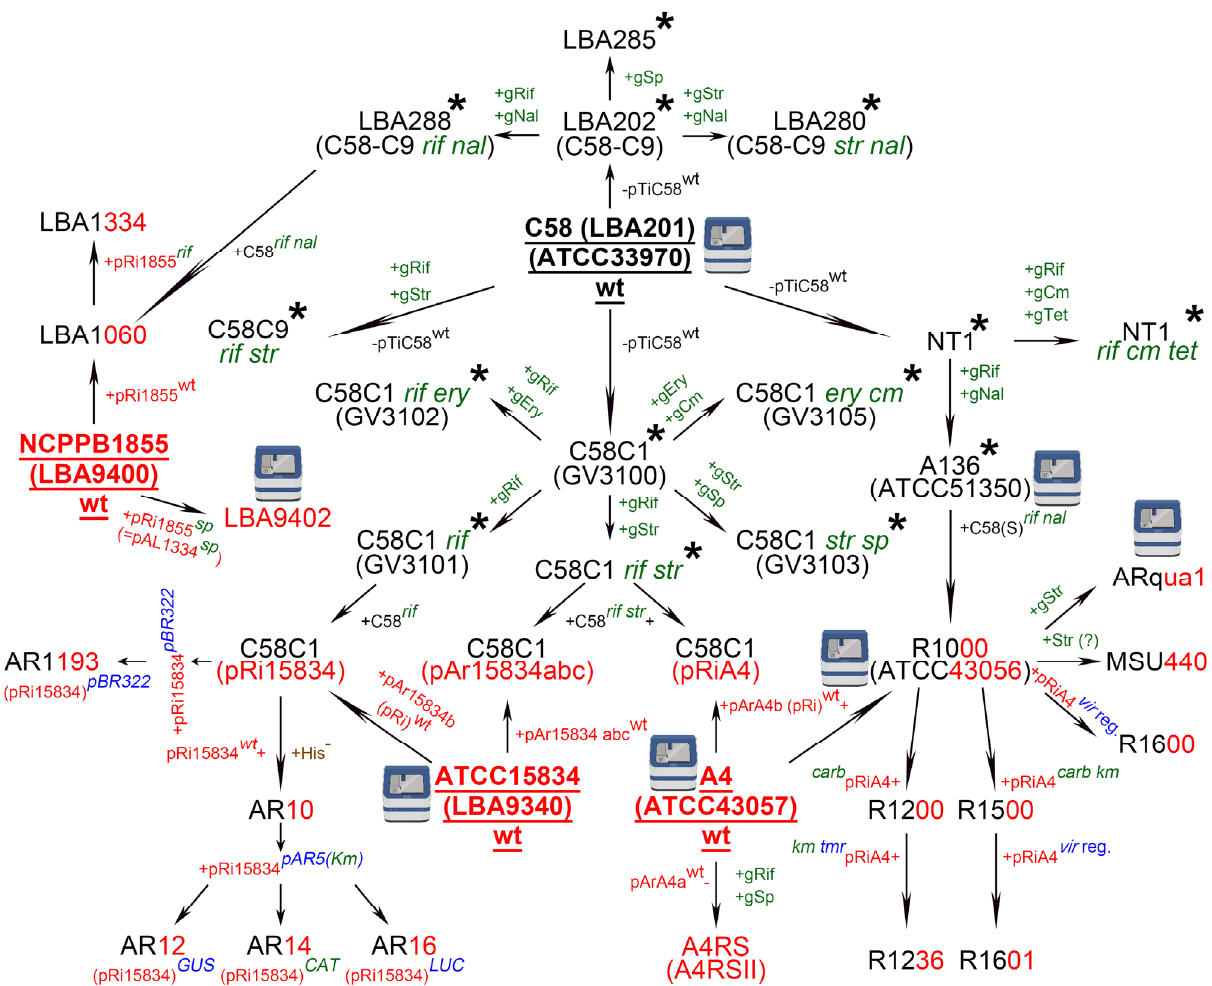
Figure 1. Relationships between Agrobacterium rhizogene s and Agrobacterium tumefaciens strains. A. rhizogene s strains are given in red, A. tumefaciens strains in black, transconjugants between A. rhizogene s and A. tumefaciens are given in both colors. The abbreviations of the four main